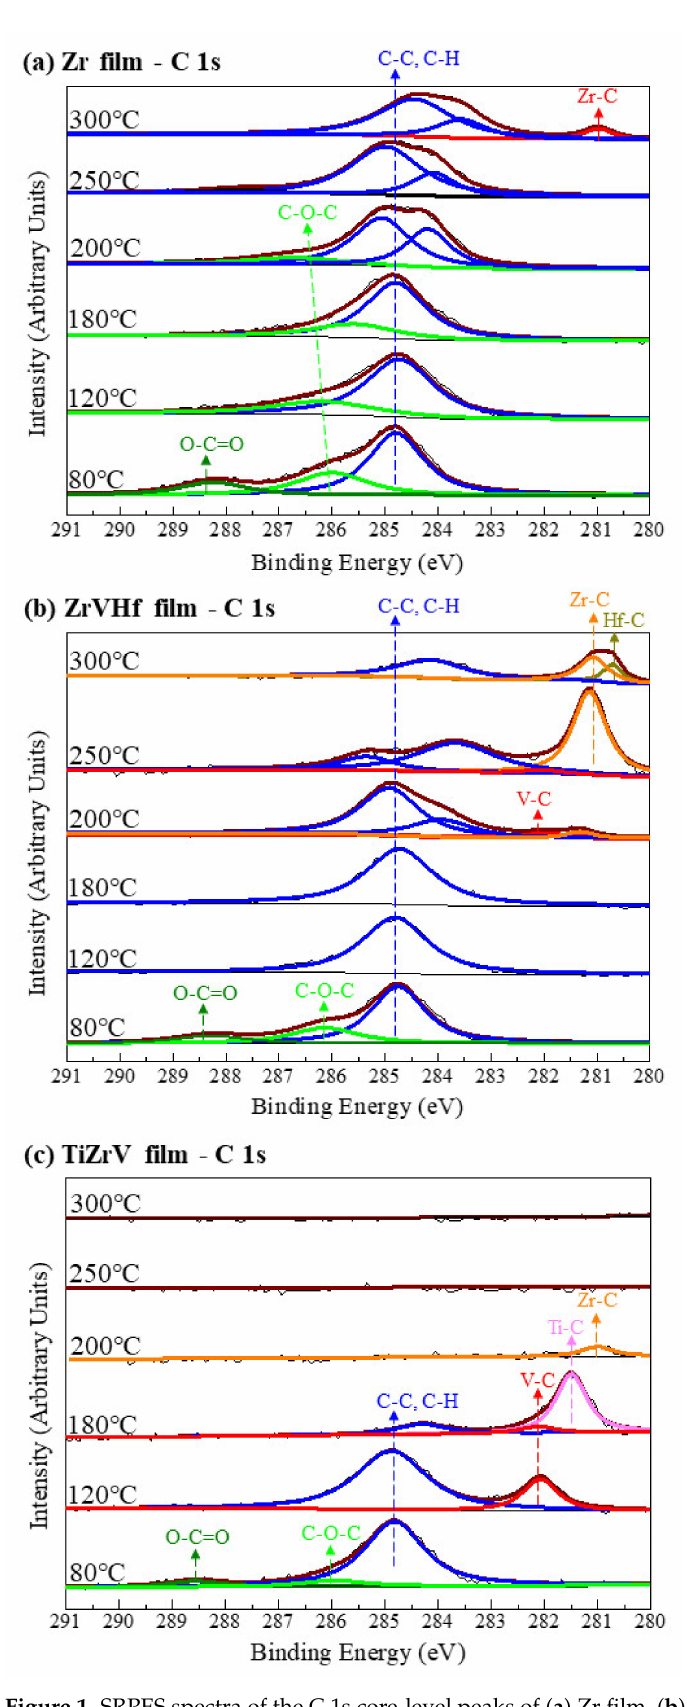
Figure 1. SRPES spectra of the C 1s core-level peaks of ( a ) Zr film, ( b ) ZrVHf film and ( c ) TiZrV film recorded after heating at various